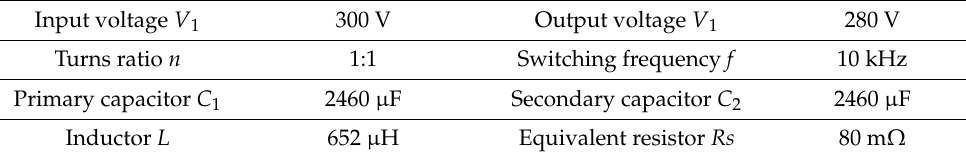
Figure 7. Experimental platform. Table 2. System Parameters. Table 2. System Parameters.